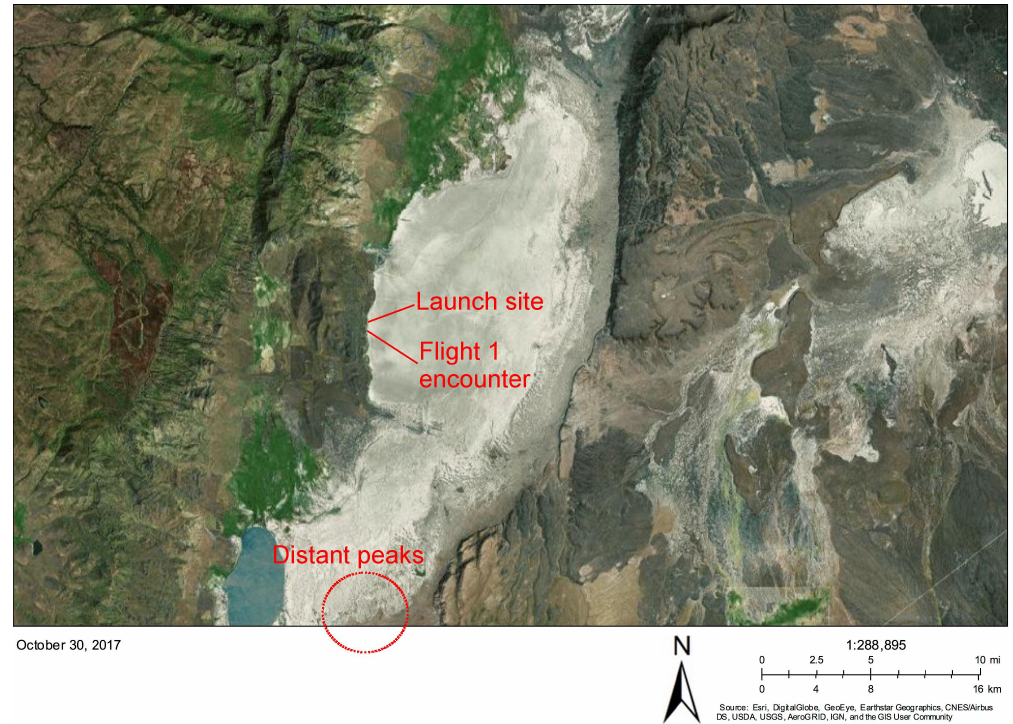
Figure 1. Landsat image of Alvord Desert, courtesy of NASA Goddard Space Flight Center and the U.S. Geological Survey. The figure shows the approximate launch site, adjacent to the playa access road, and the location of the Flight 1 dust devil encounter. The distant peaks against which we estimated parallax are also